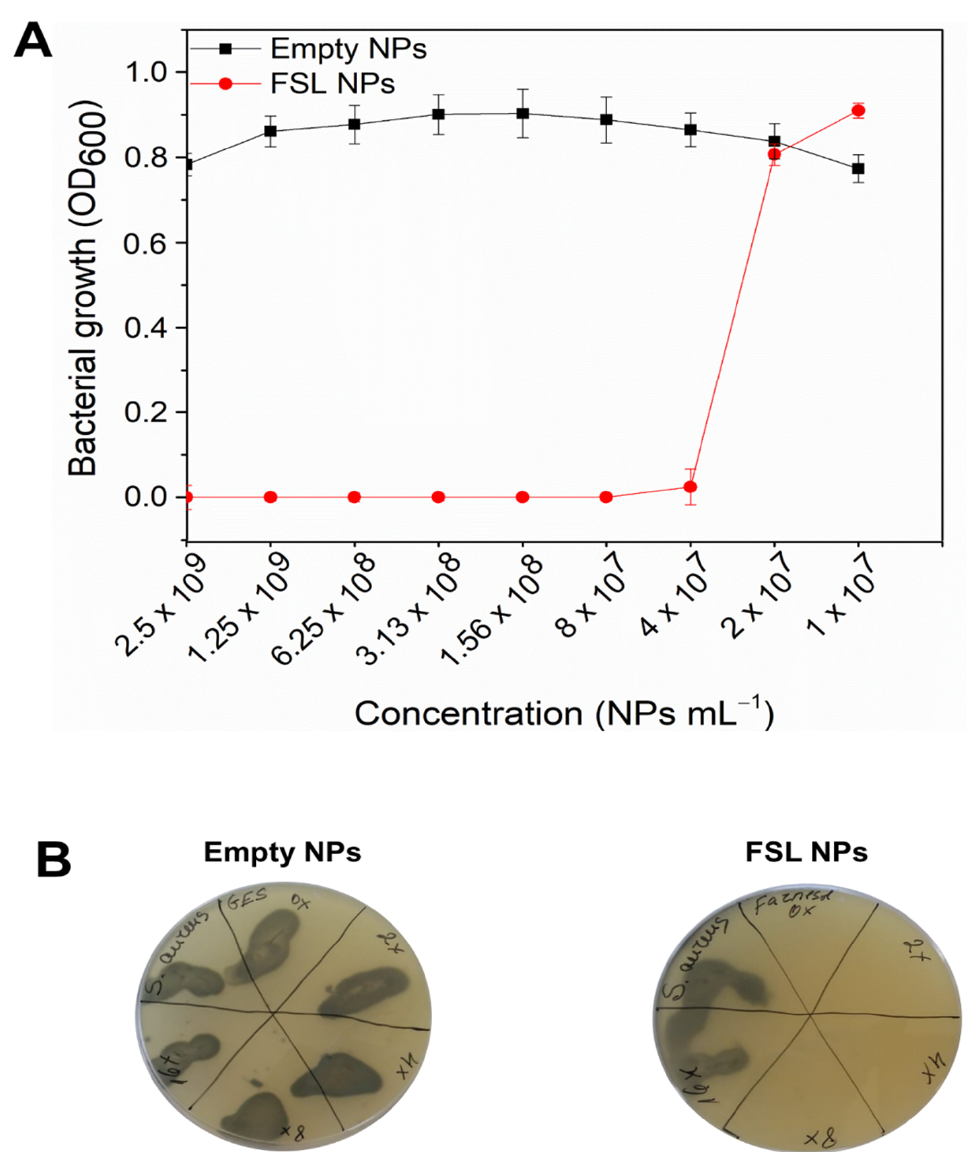
Figure 2. ( A ) S. aureus growth inhibition after 24 h incubation with empty and FSL NPs at different concentrations. ( B ) Bacterial survivor and representative images after culturing the samples on specific agar plates.